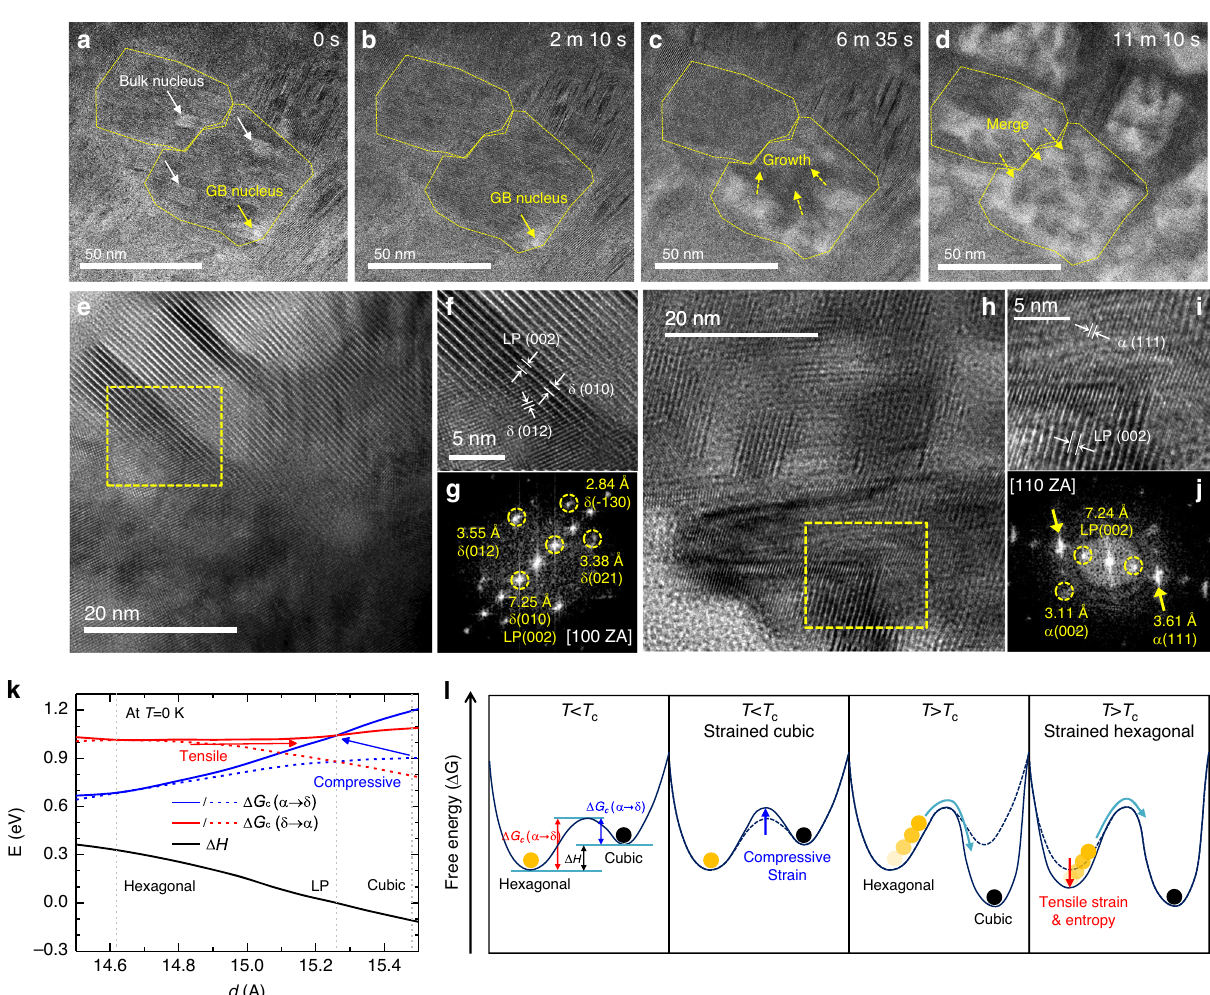
Fig. 2 Transmission electron microscopy (TEM) images and density functional theory (DFT) calculations. a – d In situ TEM images of the δ -FAPbI 3 fi lm annealed at the phase conversion temperature for different times. The relatively bright spots are the cubic phase nuclei transformed from the hexagonal phase. High-resolution TEM images of FAPbI 3 fi lms incorporated with 3.33 mol% FPEA 2 PbI 4 e , f , before and h , i after the phase conversion process. f , i Magni fi ed TEM images of the regions highlighted with yellow dashed boxes in ( e ) and ( h ), respectively. g , j Corresponding fast Fourier transform (FFT) analysis of images ( f ) and ( i ), respectively. Figure 2e – j are from samples prepared by scratching off the fi lms from the substrate. k DFT-calculated free energy barriers ( Δ G c s) for phase conversion from cubic to hexagonal ( α → δ ), from hexagonal to cubic ( δ → α ), and formation enthalpy of the cubic phase ( Δ H ) with respect to that of the hexagonal phase. Dashed lines and solid lines indicate Δ G c without and with strain, respectively. The interlayer spacing of the strain-free hexagonal phase, layered perovskite and cubic phase are indicated with gray colored dashed vertical lines (d-spacings of DFT optimized structures). l Schematic free energy diagrams for the hexagonal and cubic phased FAPbI 3 at different temperatures and strain condition. T is temperature and T c is the temperature for phase